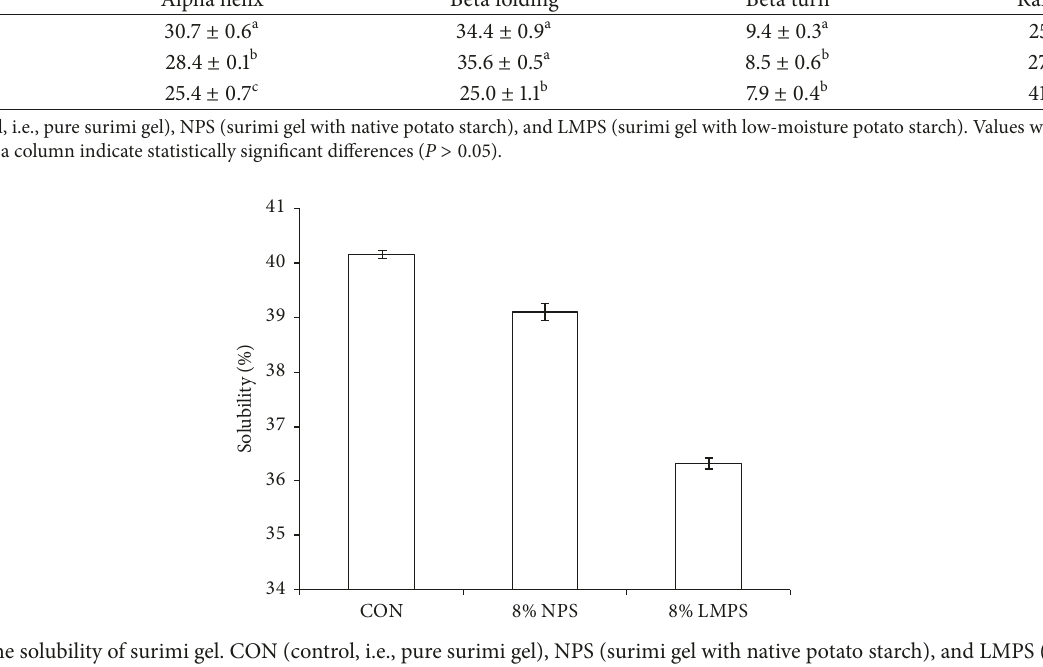
Figure 1: The solubility of surimi gel. CON (control, i.e., pure surimi gel), NPS (surimi gel with native potato starch), and LMPS (surimi gel with low-moisture potato starch).